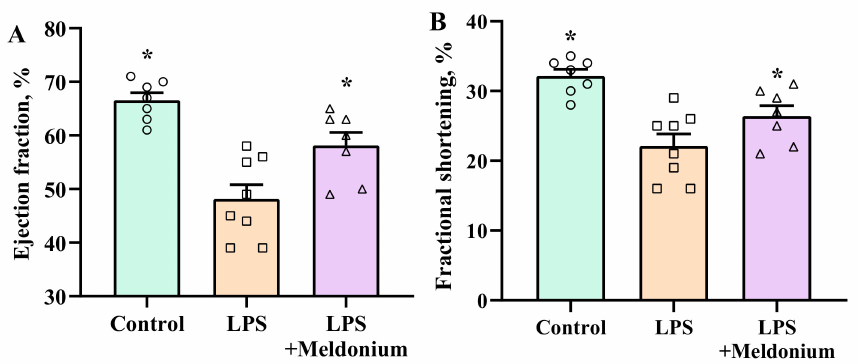
Figure 4. Effects of meldonium pretreatment on the lipopolysaccharide (LPS)-induced decrease in ( A ) ejection fraction and ( B ) fractional shortening. Pretreatment with meldonium significantly attenuated the development of the inflammation-induced decrease in the ejection fraction and fractional shortening of the left ventricle. The results are shown as the mean ± SEM of 7 to 8 animals. * p < 0.05 vs. the LPS group, one-way ANOVA followed by Dunnett’s multiple comparison